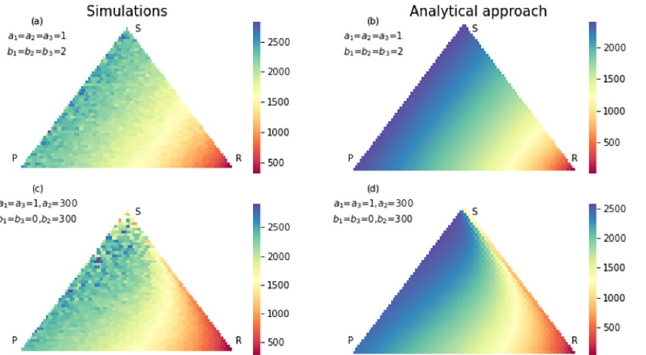
Fig 7. The simulation (a) and analytical (b) results for conditional fixation time of strategy rock for an RSP game with a neutral selection. The size of the population is 50. In (c) and (d) same results were shown for a strong selection in favor of paper strategy and detriment of rock strategy. Due to strong selection against strategy rock, conditional fixation time increase for all states of simplex.